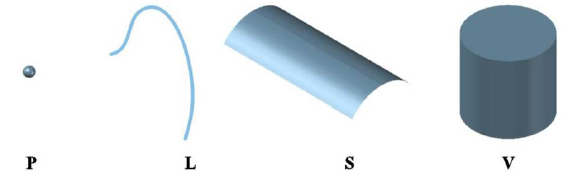
Figure 2: The four space elements and their notations.